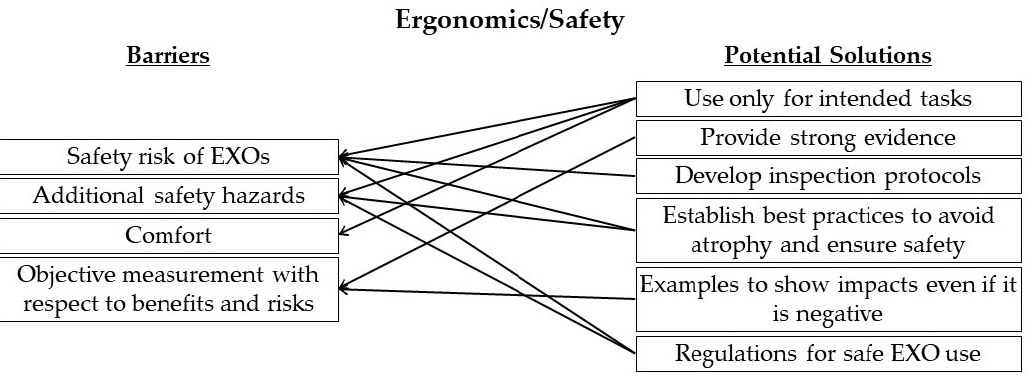
Figure 6. Mapping of potential solutions to identified barriers in the ergonomics/safety category.